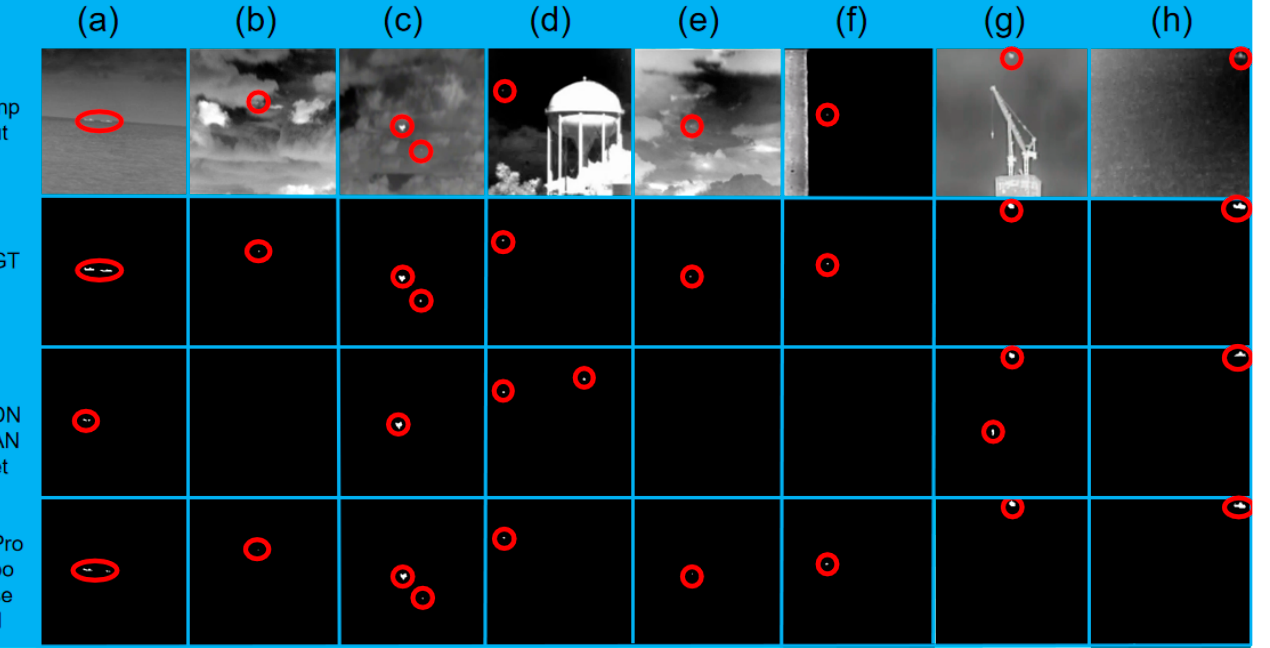
Figure 14. Comparison of detection results with DNANet, in which the subfigures ( a – h ) are some experimental samples in recognition with red circles containing targets, the 1st line shows original pictures, 2nd line shows the ground truth of the recognition results, 3rd line shows the recognition results of DNANet, and the last line shows the recognition result of the proposed method in this paper.